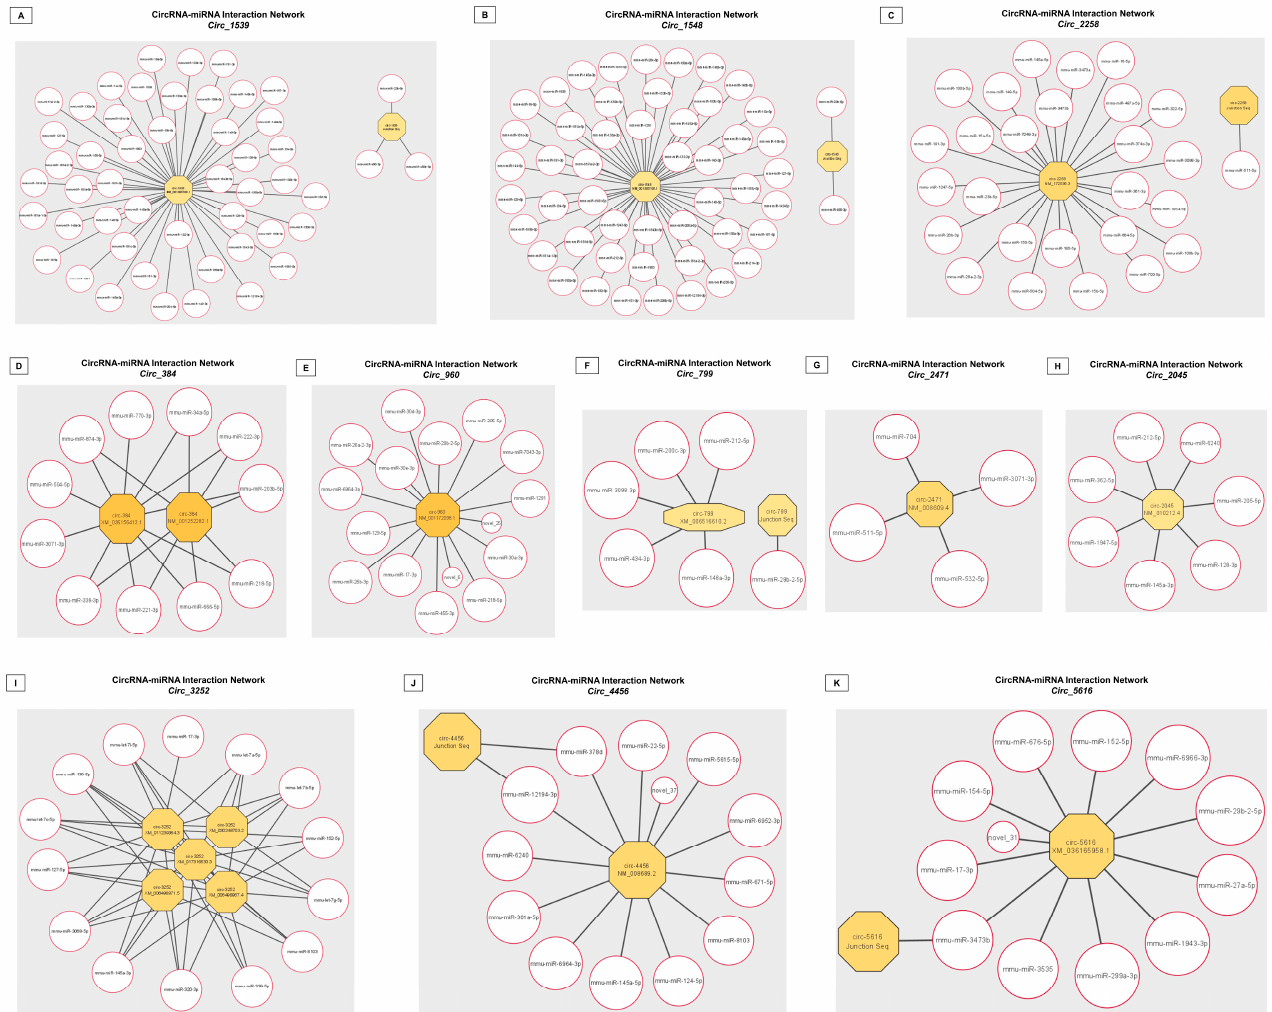
Figure 9. ( A – K ) CircRNA-miRNA interactions for the significantly altered CircRNAs. miRNA partners were identified and sorted for all statistically significant differentially expressed circRNAs– ( A ) Circ_1539 , ( B ) Circ_1548 , ( C ) Circ_2258 , ( D ) Circ_384 , ( E ) Circ_960 , ( F ) Circ_799 , ( G ) Circ_2471 , ( H ) Circ_2045 , ( I ) Circ_3252 , ( J ) Circ_4456 , and ( K ) Circ_5616 . Network images were prepared with Cytoscape. p < 0.05 were considered statistically